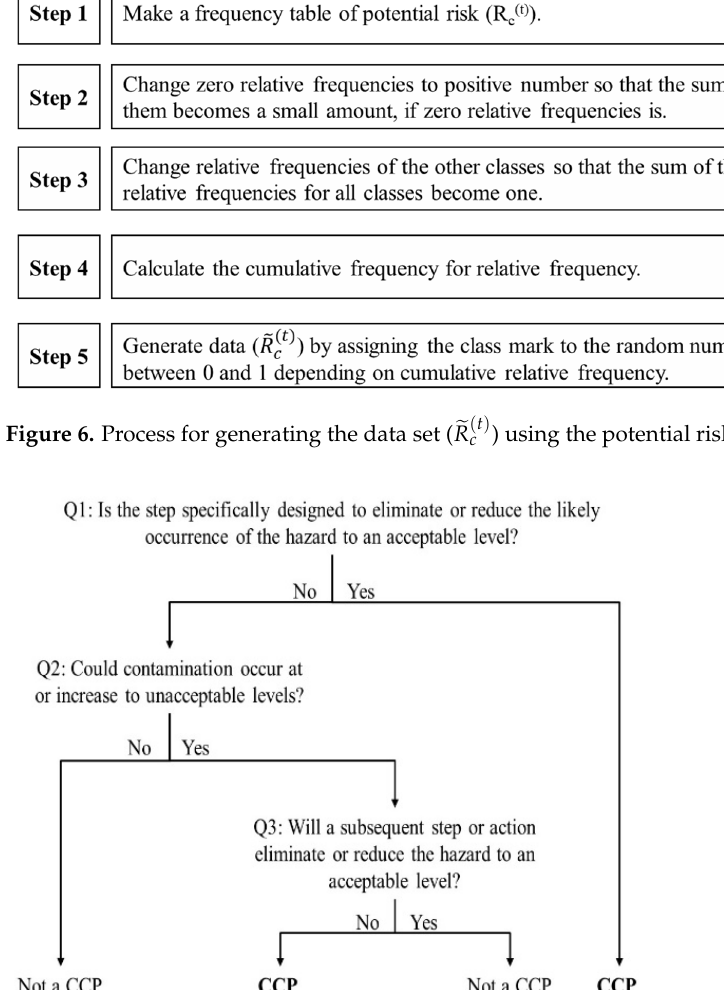
Figure 6. Process for generating the data set ( 𝑅(cid:3560)